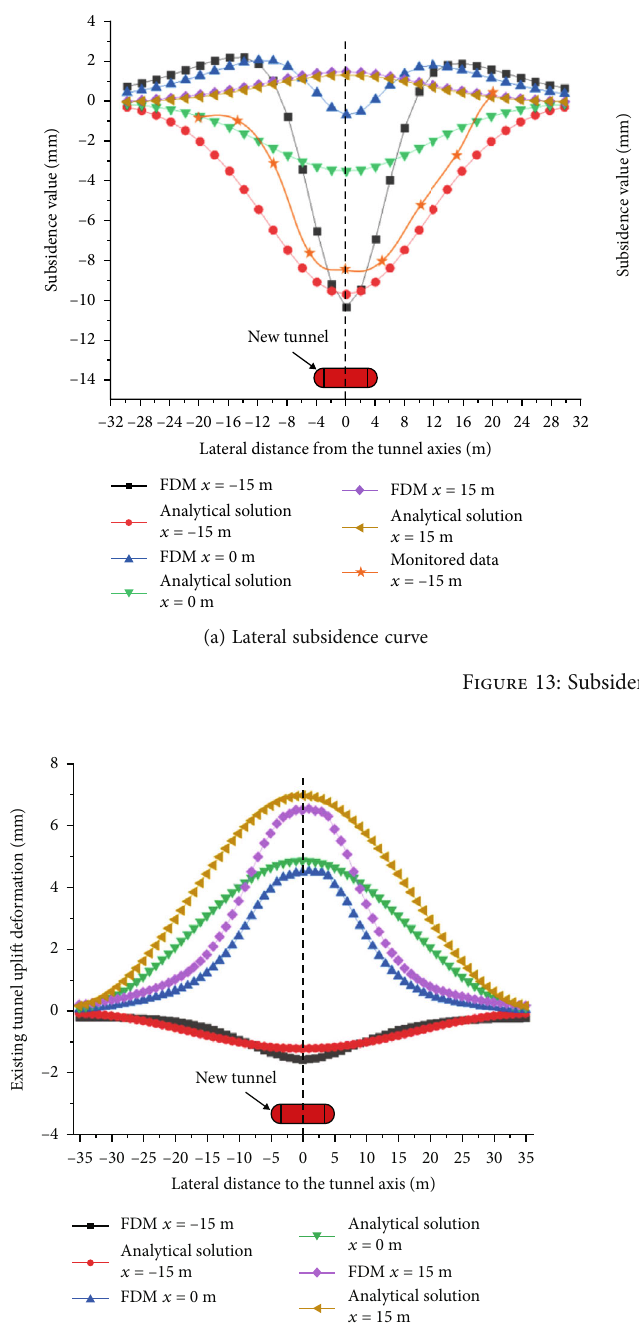
Figure 14: Lateral deformation curve of existing shield